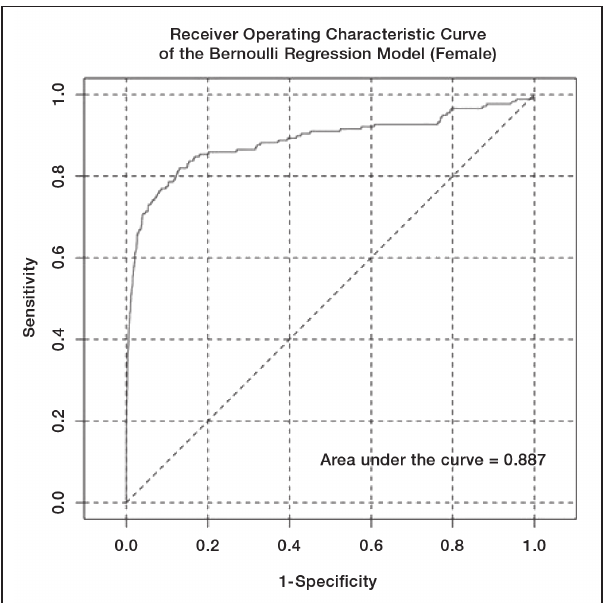
Figure 1) ROC curve for the Bernoulli regression output for men to predict C282Y homozygotes in 17,323 Caucasian men from the Hemochromatosis and Iron Overload Screening (HEIRS) Study. The area under the curve was 0.908 and the Nagelkerke pseudo R-squared was 0.44